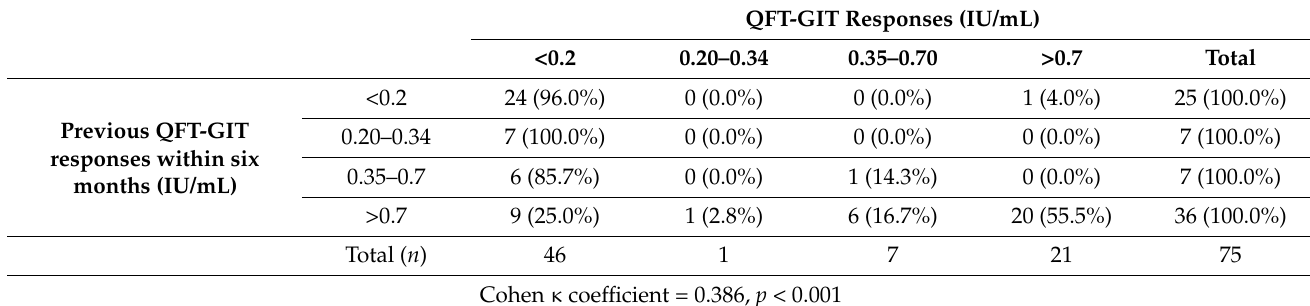
Table 2. Comparison of QuantiFERON-TB Gold In-Tube (QFT-GIT) assay results between the current study and previous QFT-GIT within the past six